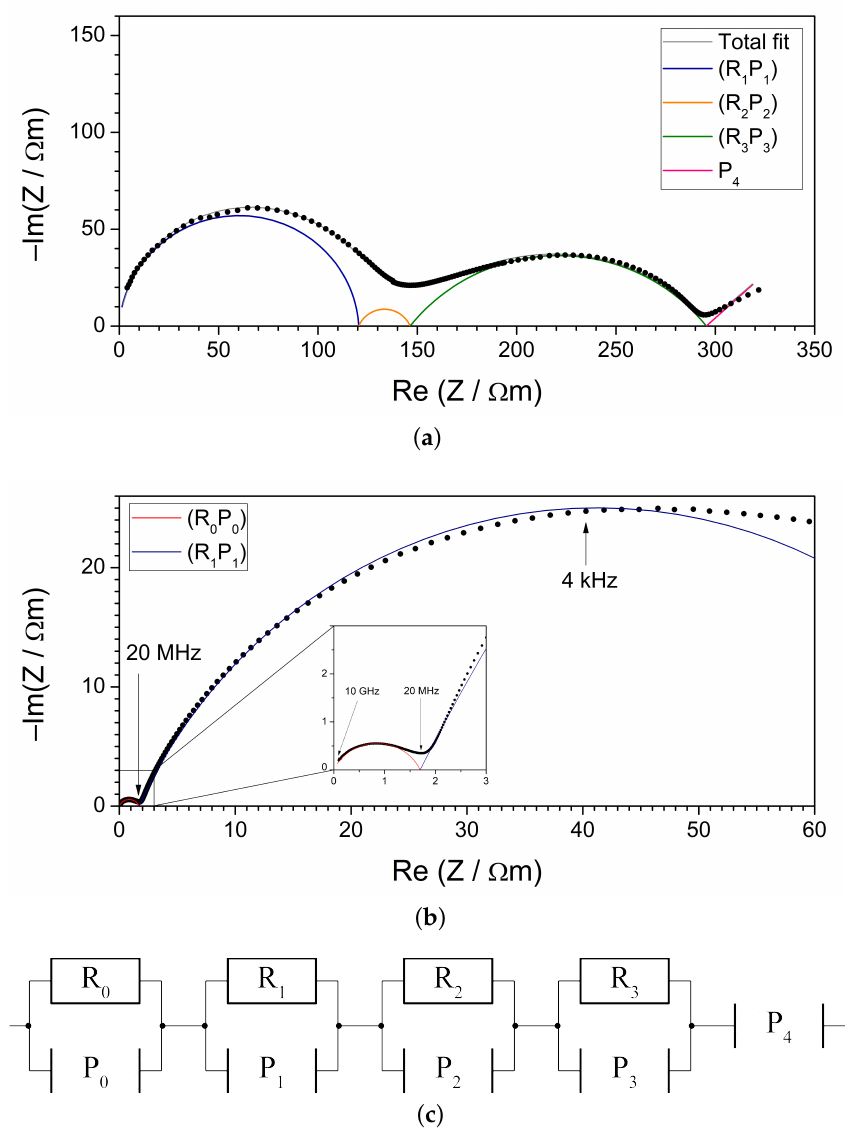
Figure 5. Exemplary impedance figures (Nyquist plots) of a nanocrystalline VV NASICON sample in ( a ) 10 mHz–5 MHz and ( b ) up to 7 GHz range. Total fits (gray lines) and partial fits of (RP) elements (colorful solid line) are included in the plots. The absolute values were normalized using the geometrical factor of the samples to show the material’s resistivity; ( c ) the equivalent circuit used for total